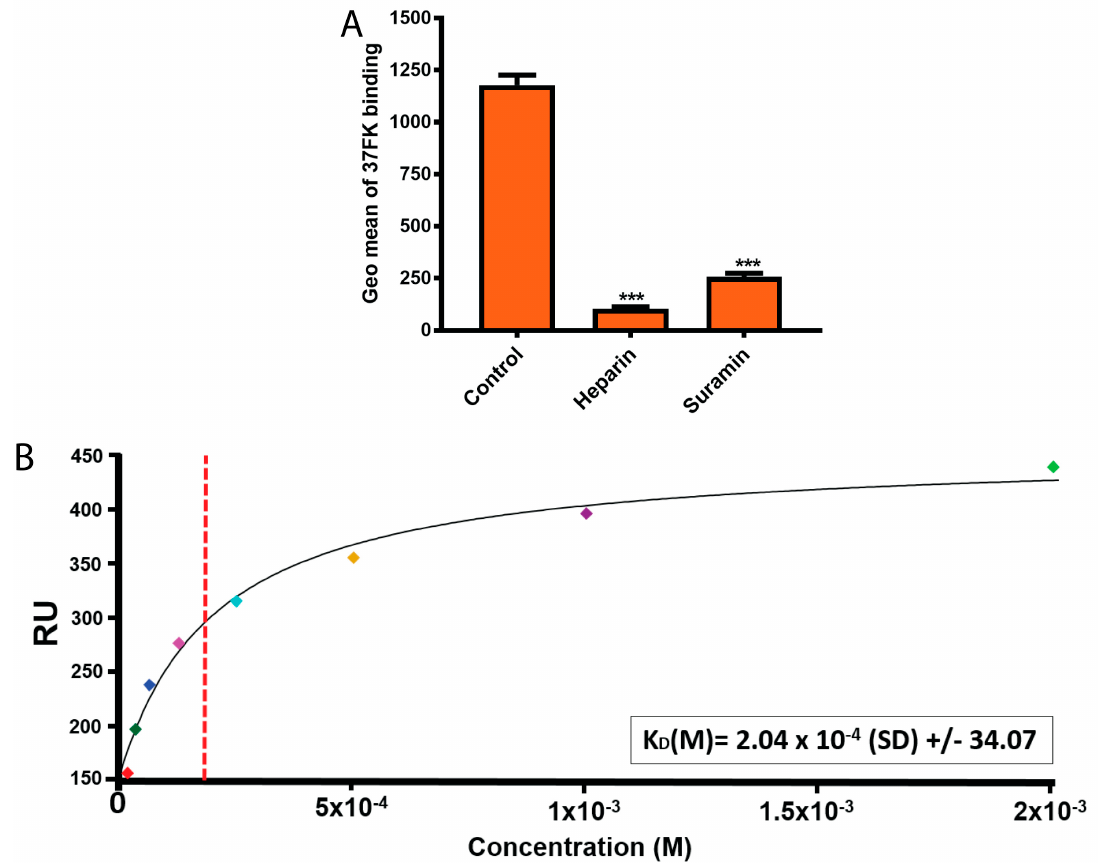
Figure 3. Suramin directly interacts with 37FK. ( A ) Binding of His-tagged 37FK, pre-incubated with heparin and suramin, to HCE cells. FK binding to cells was analyzed on the flow cytometer and the data is presented as the geometric mean of fluorescence (Geo mean). ( B ) SPR analysis of GST-tagged 37FK interaction to suramin. The red dashed vertical line represents the estimate of KD at half-maximal binding of the 37FK and suramin. The small squares in different colors represent the concentration points. Error bars represent mean ± SEM. *** P < 0.001 relative to control.